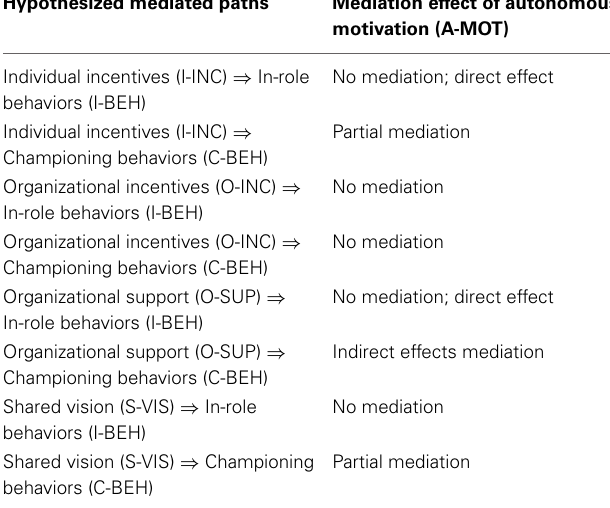
Table 7 | Mediation